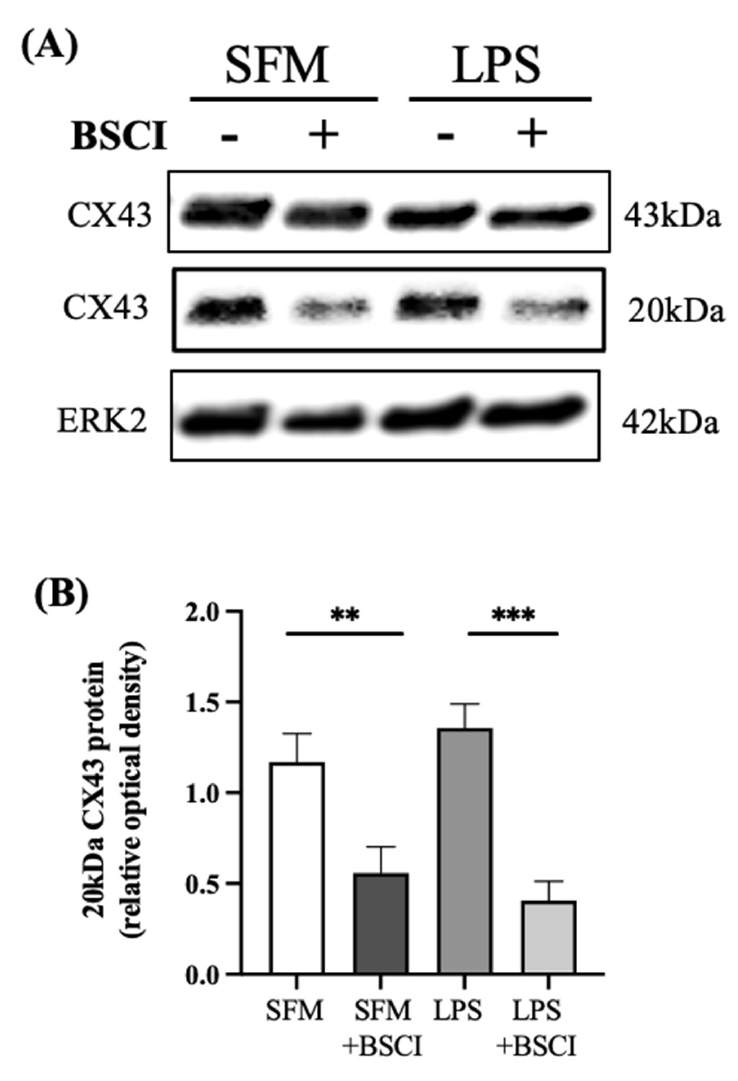
Figure 4. Effect of BSCI on protein expression of the gap junction protein CX43 in human myometrial cells. ( A ) Representative Western blot and ( B ) bar graphs showing the expression of the full length (43 kDa) and short isoform (20 kDa) CX43 protein, normalized to ERK2 protein (loading control) in human myometrial cell lines ( n = 3) treated with LPS (100 ng/mL) or vehicle (SFM) with/out BSCI (FX125L, 250 nM). Data are presented as mean ± SD. Statistical significance was determined by one-way ANOVA followed by Dunnette’s multiple comparisons test. ‘**’ denotes statistical significance at p < 0.01, and ‘***’ at p < 0.001.